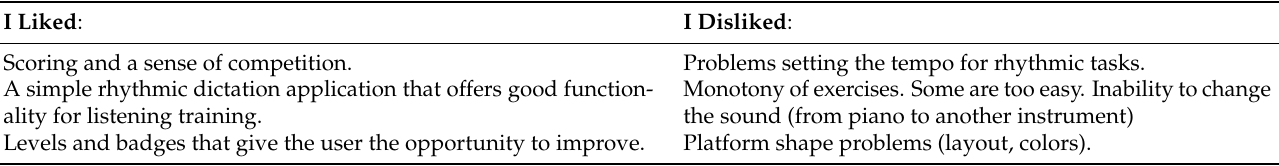
Table 1. Most frequent statements in the students’ responses, regarding the liked and disliked aspects of the